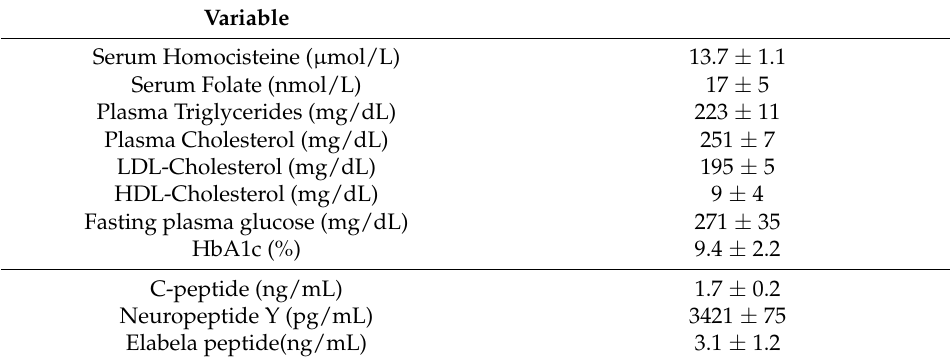
Table 7. Metabolic Characteristics in patient with major amputation (16